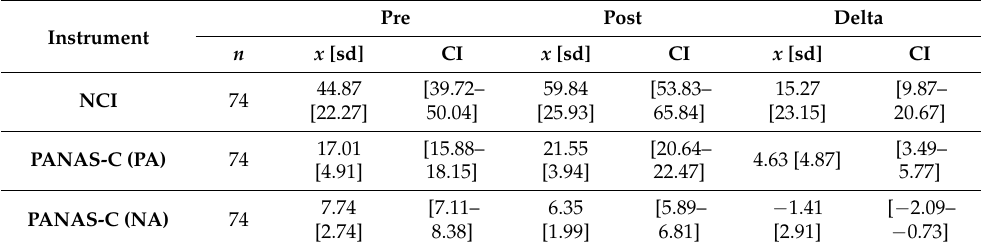
Table 1. Sample size, mean, confidence interval and pre–post data for schools A–D.